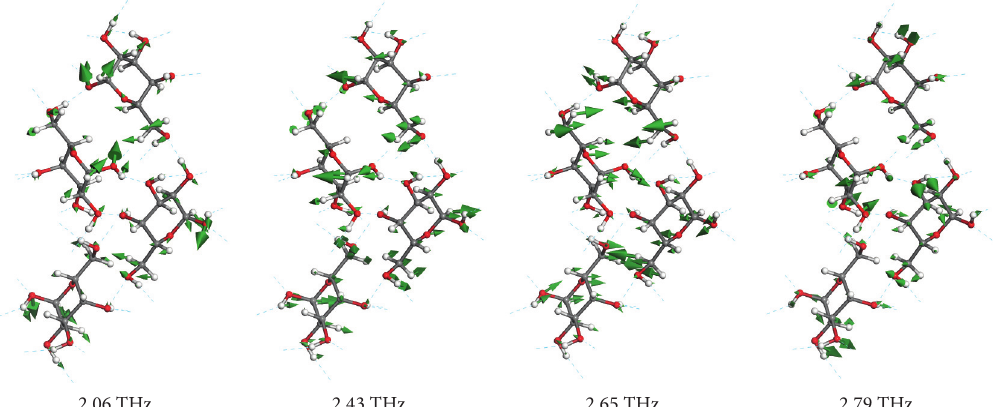
Figure 6: The displacement vector representations of the PBE calculated vibrational modes of galactose at 2.06 THz, 2.43THz, 2.65THz, and